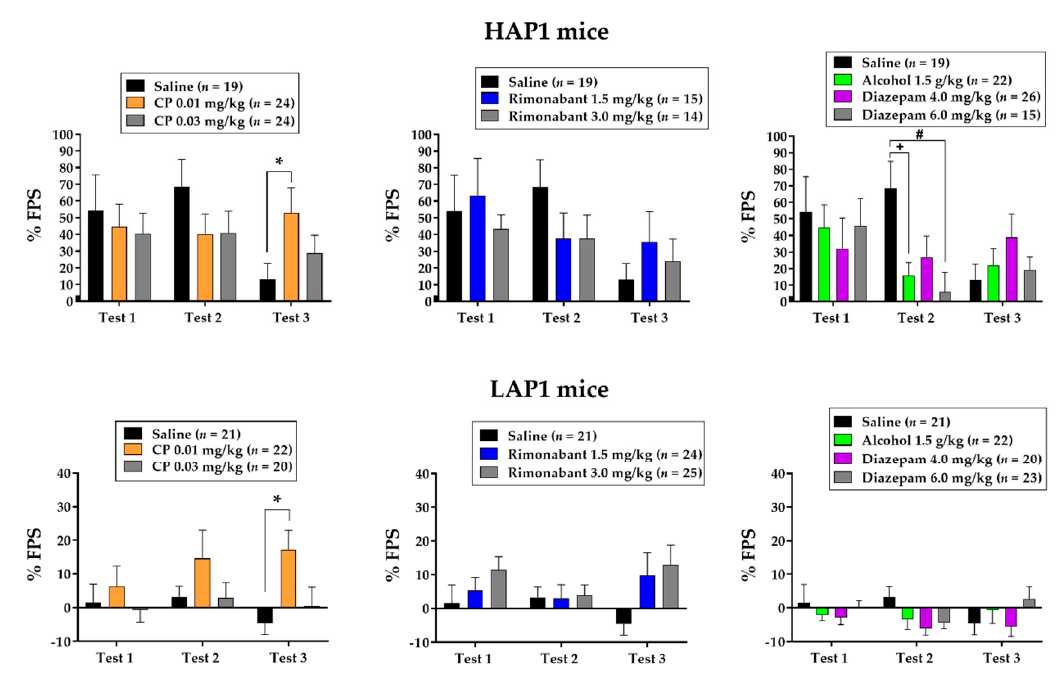
Figure 4. Mean (±SEM) % FPS in HAP1 male and female (top panels) and LAP1 male and female (bottom panels) mice that received saline, 0.01 mg/kg and 0.03 mg/kg CP55940 (left panels), 1.5 mg/kg and 3.0 mg/kg rimonabant (middle panels), or 1.5 g/kg alcohol, 4.0 mg/kg diazepam, and 6.0 mg/kg diazepam (right panels). Drugs were given 30 minutes prior to Test 1 and Test 2 which occurred 24 and 48 hrs after fear ‐ conditioning, respectively. Test 3 occurred 216 hrs (9 days) after Test 2 in a drug ‐ free state. * p < 0.01 CP55940 0.01 mg/kg > Saline (collapsed across Line); + p < 0.05, Saline > Alcohol 1.5 g/kg; # p < 0.01, Saline>Diazepam 6.0 mg/kg.